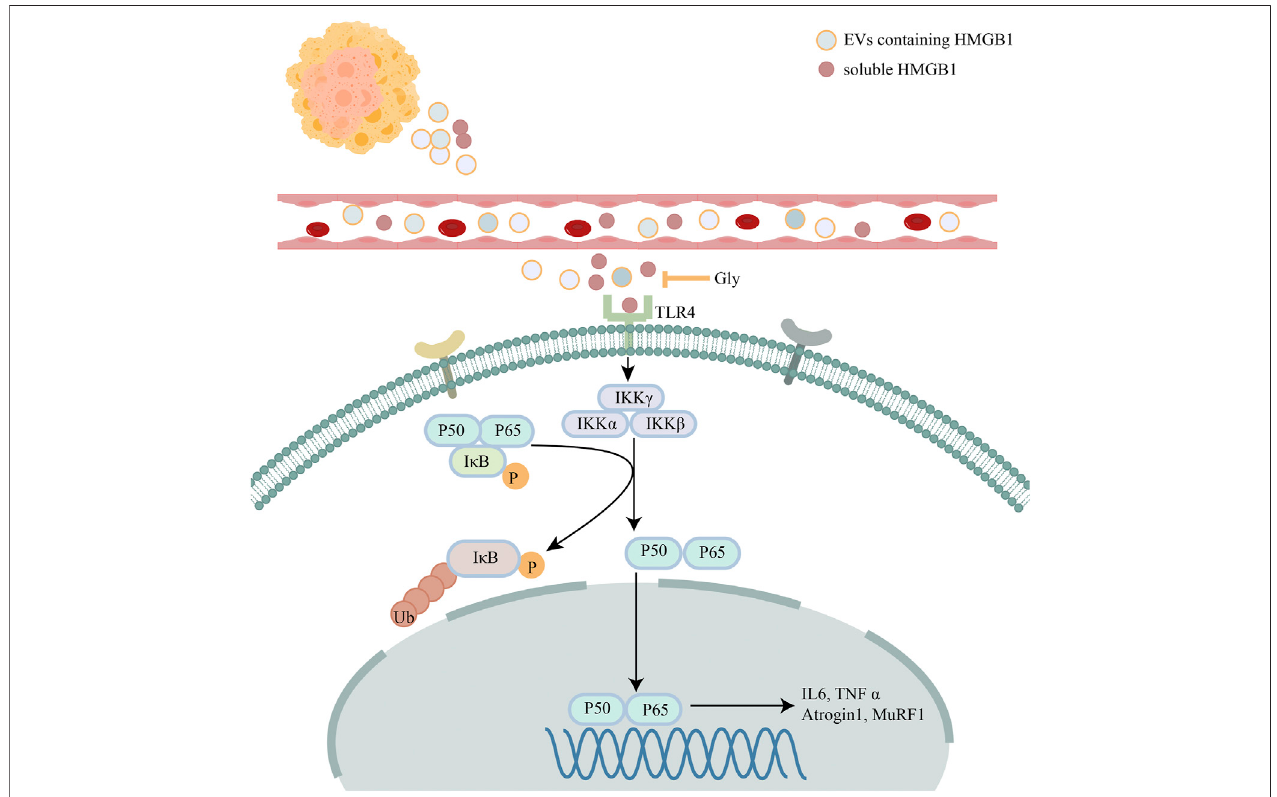
FIGURE9| Schematicdiagramdescribing theroleofHMGB1.Schematicdiagramdescribingthemechanism ofHMGB1mediatedmusclewasting thoughTLR4/ NF- κ B signaling pathway.